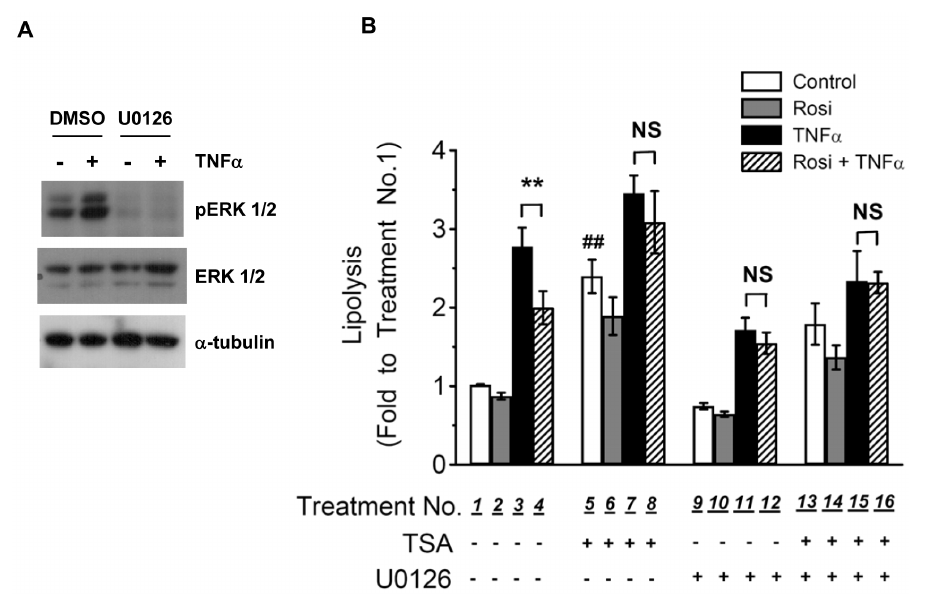
Figure 8. TSA treatment modulates Rosi-mediated suppression of TNF a -induced lipolysis through ERK1/2. (A) 3T3-L1 adipocytes were pretreated with vehicle (DMSO) or 25 m M U0126 for 1 h, followed by treatment with or without 10 ng/ml TNF a for 30 min. Cellular proteins were solubilized and subjected to SDS-PAGE and Western blot analysis with the indicated antibodies. (B) 3T3-L1 adipocytes were treated with vehicle (Control), 1 m M Rosi (Rosi), 10 ng/ml TNF a (TNF a ), or both (Rosi + TNF a ), together with DMSO (bars 1-4), 660 nM TSA (bars 5-8), 25 m M U0126 (bars 9- 12), or both (bars 13-16) for 24h. Glycerol released into the media and protein concentrations of cell lysate were determined as described in Materials and Methods . Each point represents the mean 6 S.E. of four independent experiments. Asterisks denote significant differences (**: p , 0.01). NS, not